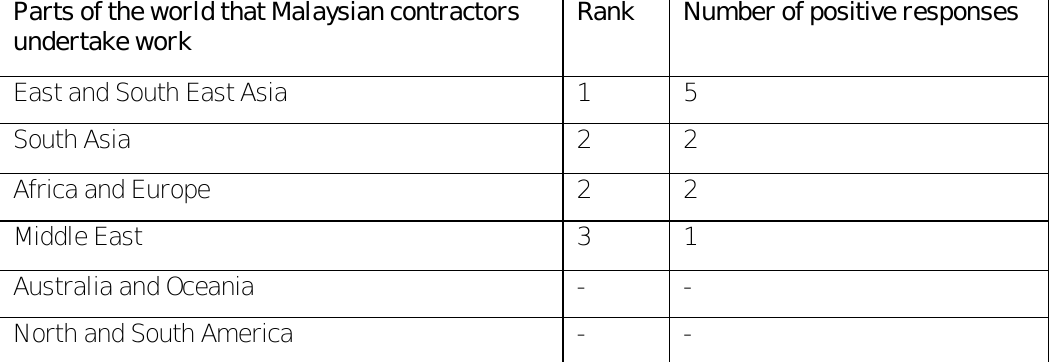
Table 5: Parts of the world where contractors undertake work Parts of the world that Malaysian contractors